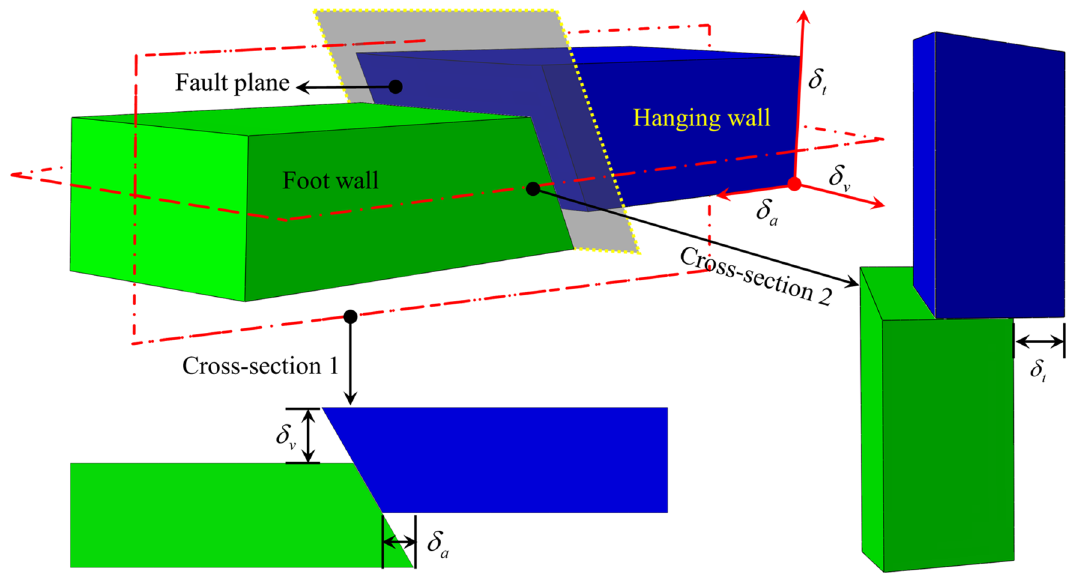
Figure 1. Schematic of the oblique-reverse fault